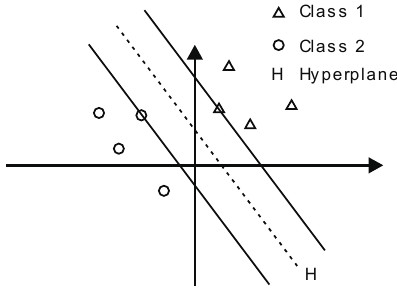
Figure 5. Support Vector Machine.